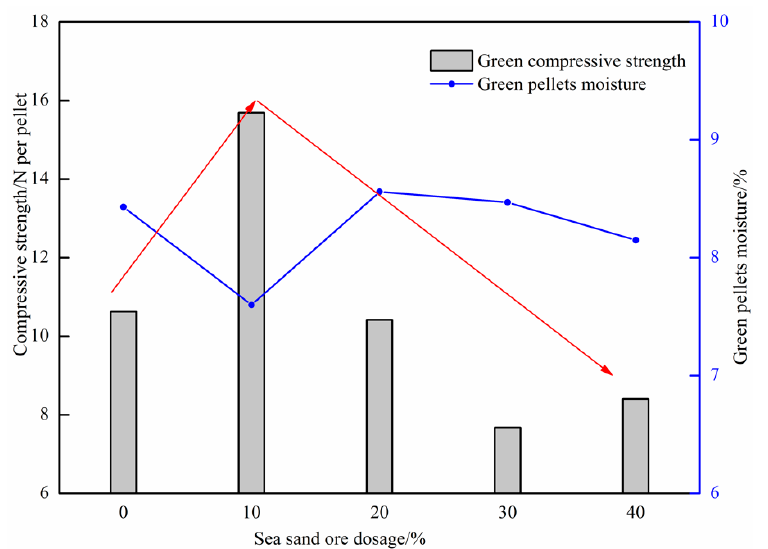
Figure 6. Compressive strength and moisture of the green pellets with different dosages of sea sand ore used.